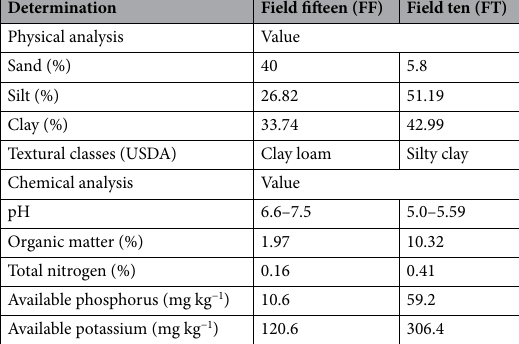
Table 3. Characterization of soil properties of the experimental region.